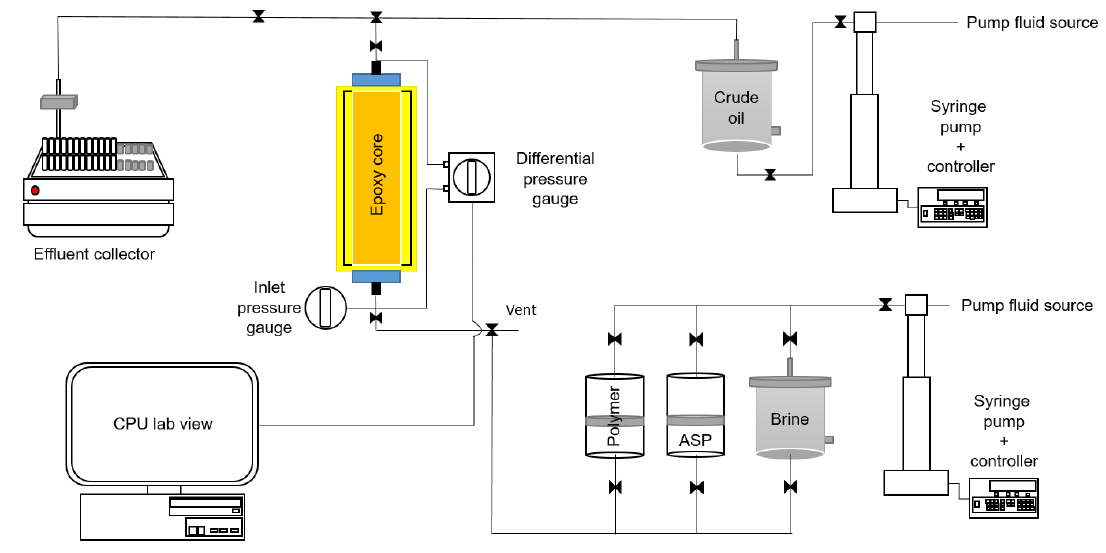
Figure 1. Experimental apparatus for coreflooding tests.